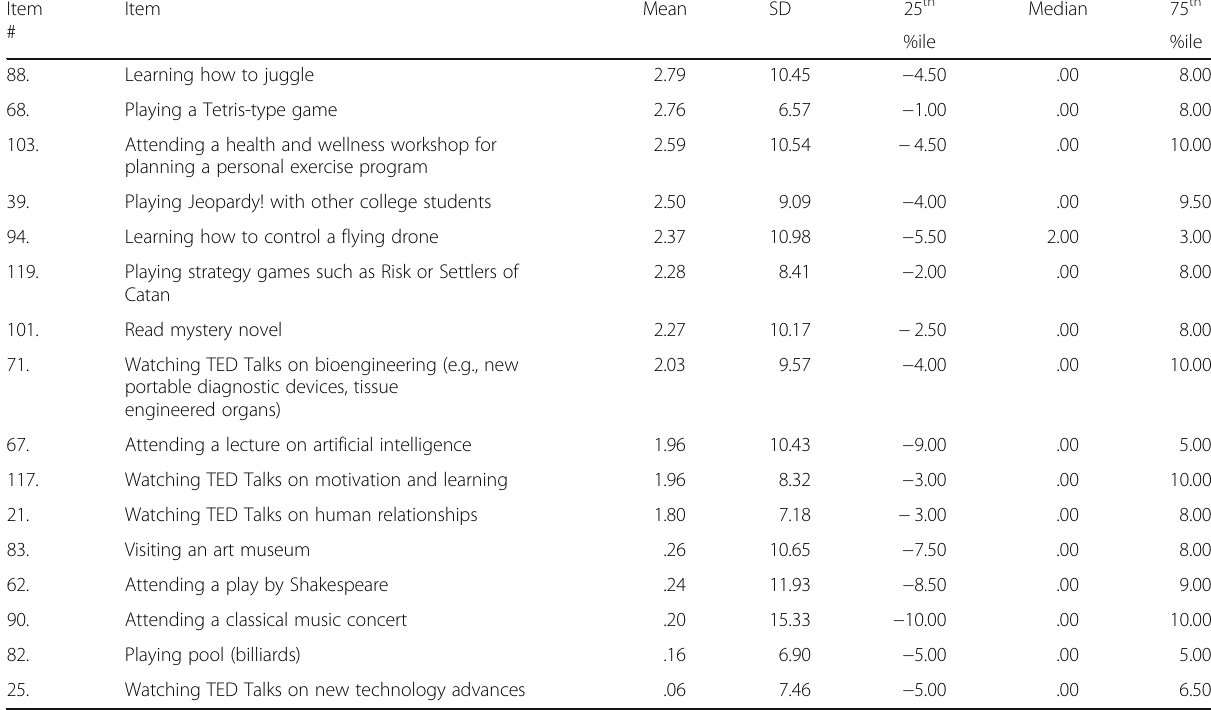
Table 1 Disutility judgments. Task items and descriptive statistics (mean, SD, 25%ile, median, 75%ile) (Continued) Item